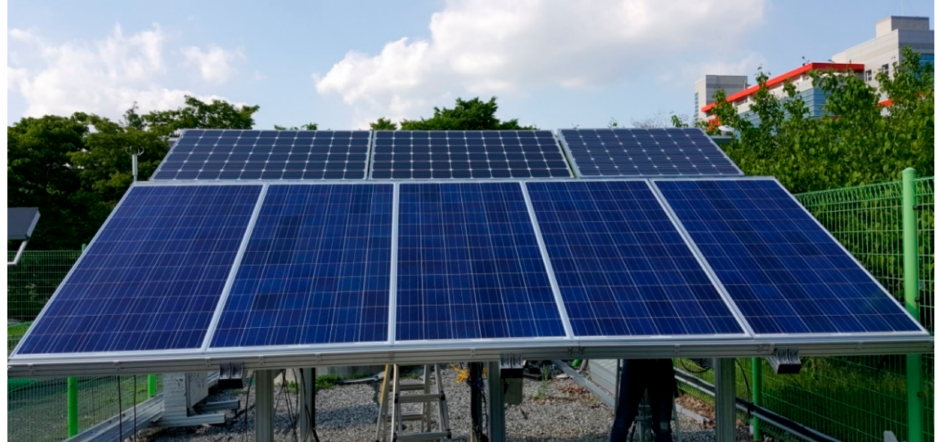
Figure 2. Fixed testbed system with the maximum setup of eight modules. The data time step is 30